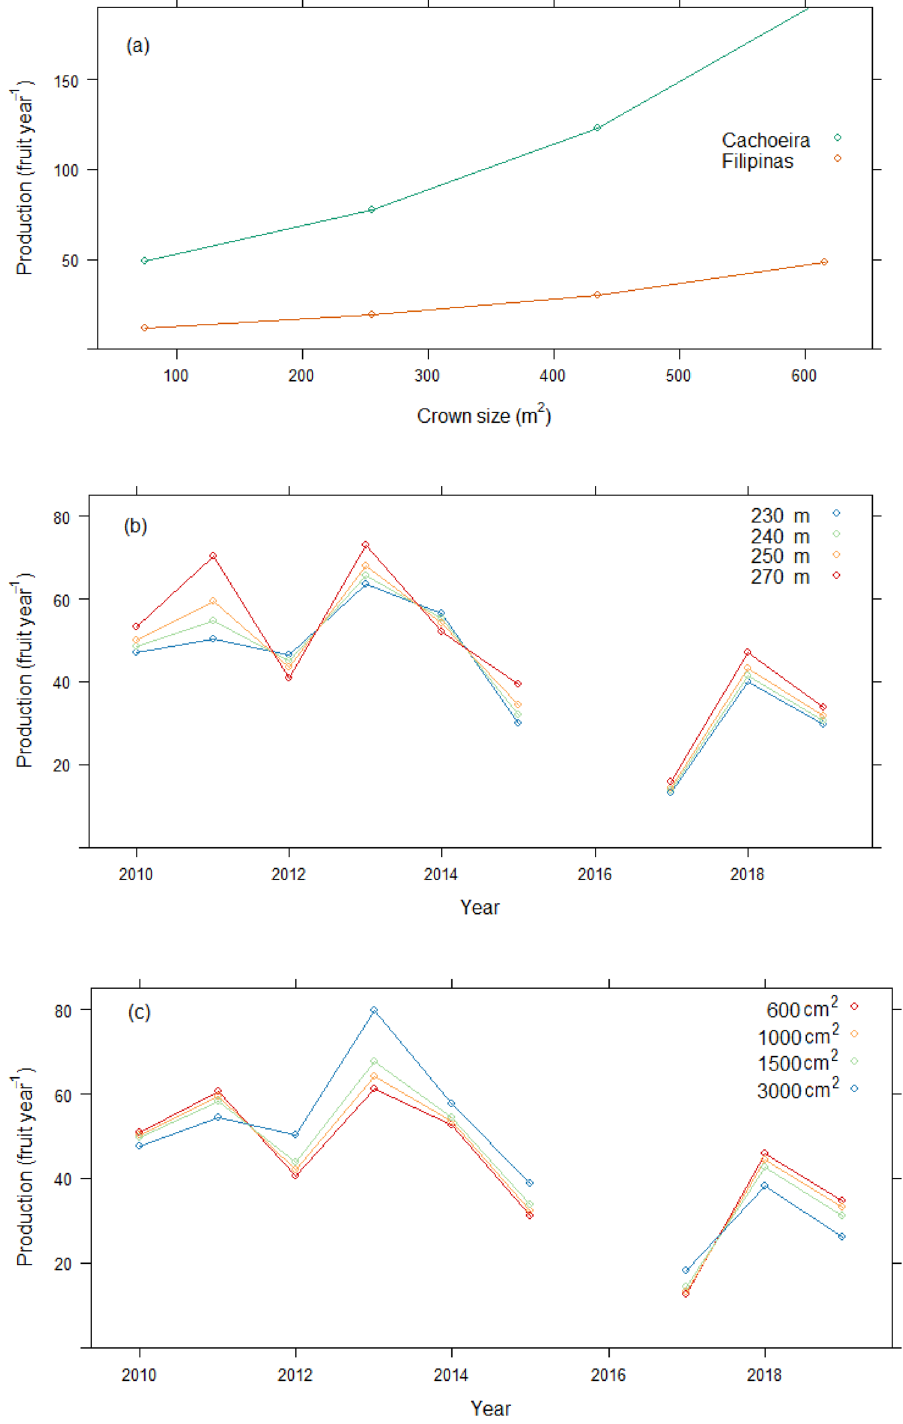
Figure 3. Model 1 marginal mean values of annual fruit production: ( a ) by site and crown size (m 2 ), ( b ) by year and four values of elevation (m), and ( c ) by year and sapwood area (cm 2